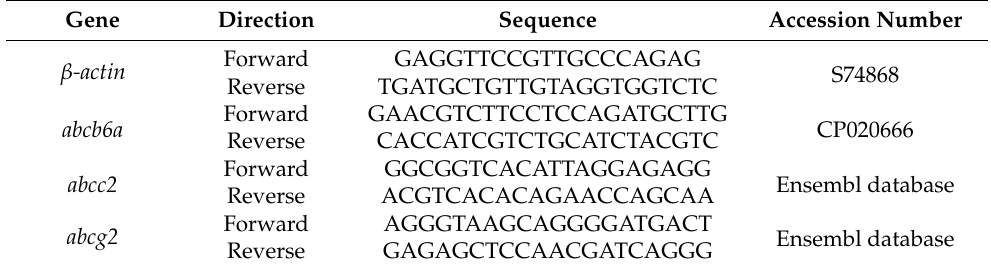
Table 2. Primer pairs used for qPCR analysis in larval medaka in the present study. Gene Direction